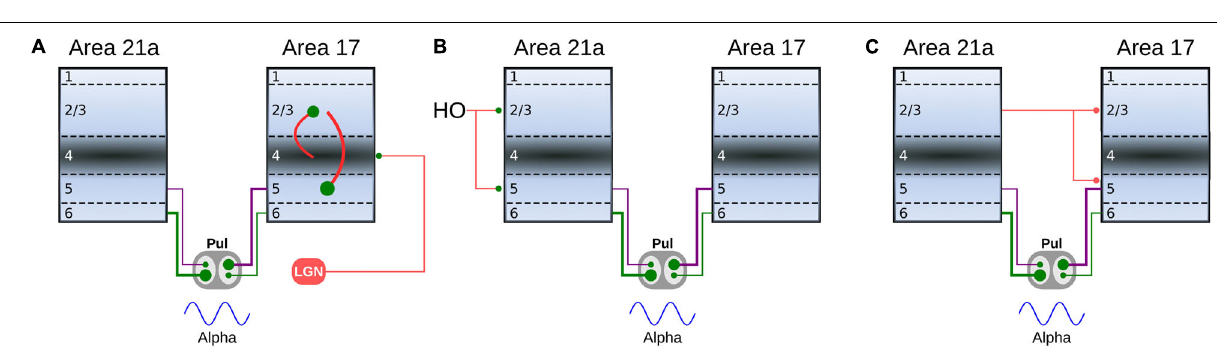
was still coupled, but connections from area 17 to the pulvinar were disconnected. Under this configuration, only 1.7% of alpha waves were generated in area 21a. In average, the pulvinar did